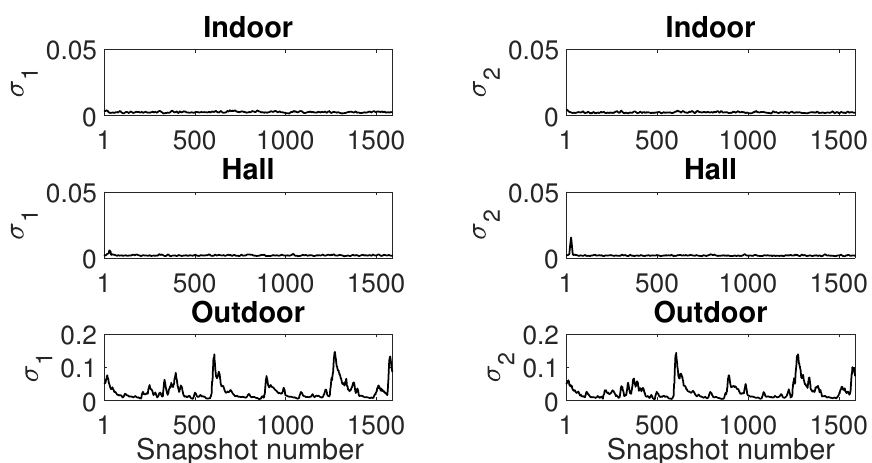
Figure 21. GMM model estimation: Sample window of 1500 with 10% of windows overlapping.